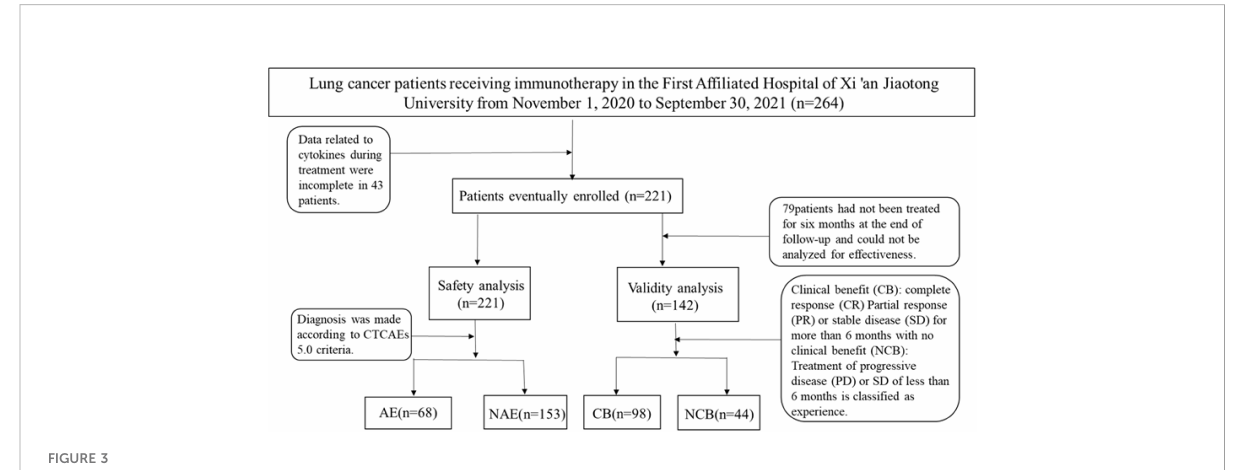
FIGURE 3 Selection process for